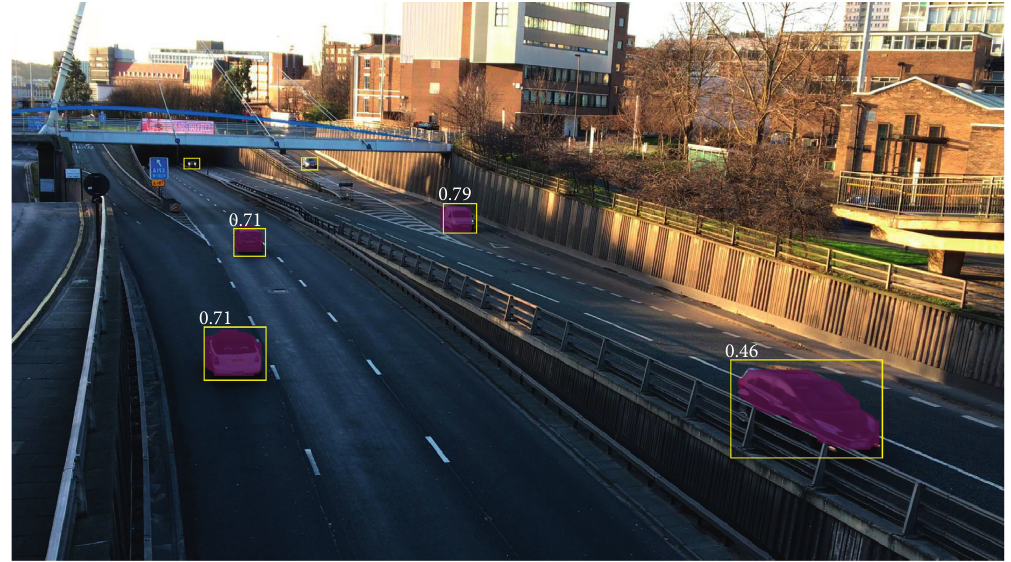
Figure 4: Accuracy of the bounding box in an image (note that two small objects are missed by the image instance segmentation algorithm.). Table 2: Annotation accuracy of human annotations for the downsampled UTS dataset.